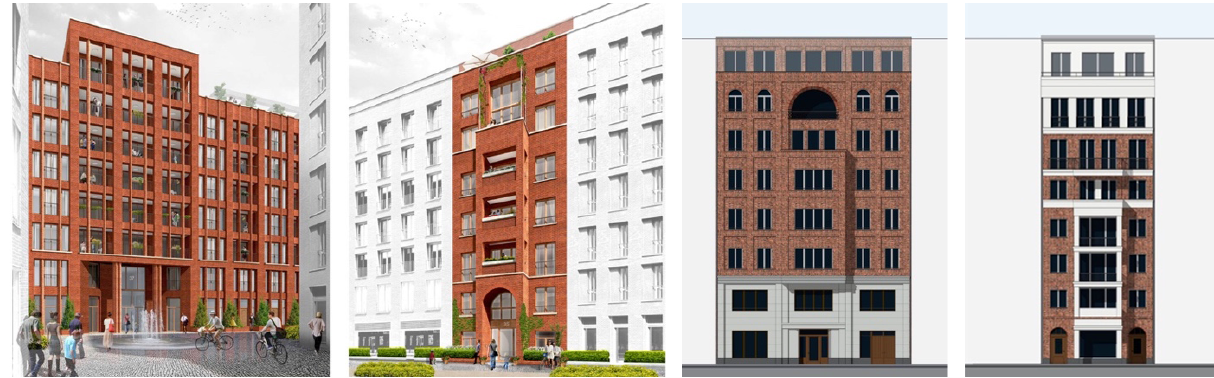
Figure 22. WerkbundStadt am Spreebord in Berlin, projects by Bernd Albers and Paul Kahlfeldt. Source: Kahlfeldt